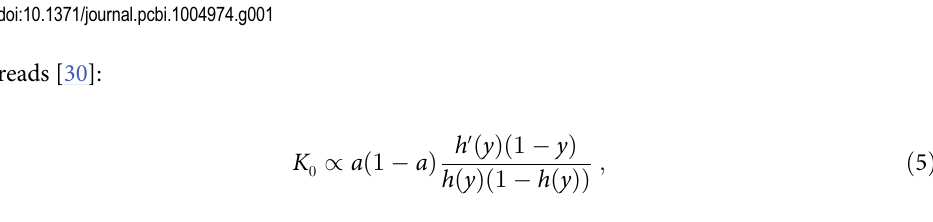
Fig 1. A sketch of the motor response curve and the dependence of the up-gradient chemotactic velocity on the running time. The curve represented in the main panel is a cartoon version of the clockwise (CW) bias vs the concentration of the second messenger CheYp of the chemotaxis pathway. Having the system set at the inflection point of the curve (blue point) would maximize the slope, i.e. the absolute sensitivity of the motor. However, the bacterial up-gradient velocity is not simply proportional to the absolute sensitivity, as discussed in the text. In particular, extending the duration of the runs can speed up the velocity as shown in the inset: the running time is reported in seconds on the abscissae while the solid line is Eq (4) with λ = 1 and the dashed line is again Eq (4) but λ changes now with τ r so as to maximize the chemotactic velocity. The upshot is that points on the motor curve which do not maximize the absolute sensitivity, like the red one, can actually yield larger up-gradient